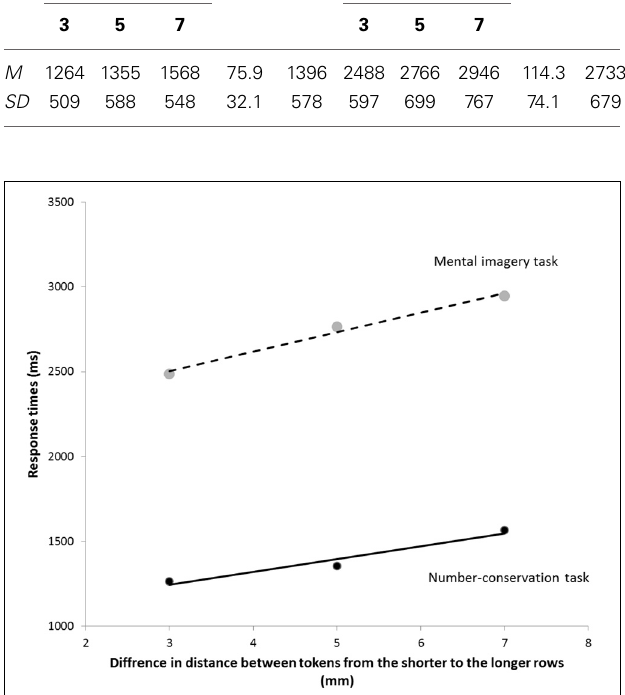
FIGURE 3 | Mean response times for the three differences in distance between the tokens in the two rows in the INT condition of the number-conservation task and the mental imagery task. Solid lines denote the best-fitting lines for the RTs in the INT condition of the number-conservation task (plain) and the best-fitting lines for the RTs in the mental imagery task